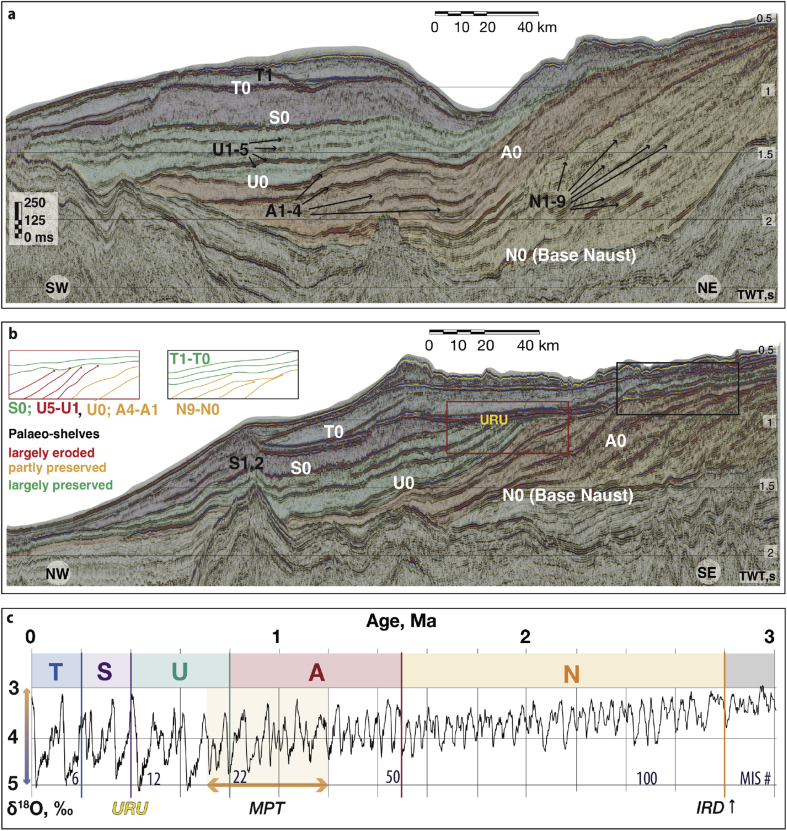
Regional seismic stratigraphy of the Naust Formation. a. From part of seismic profile GMNR94-302 (strike line) showing multiple coherent high-amplitude horizons (located in Fig. 1b). b. From part of a seismic profile GMNR94-106 (dip line) showing Naust sequences and degree of preservation of the buried surfaces (located in Fig. 1b). Surface N0 is the base-Naust. c. Tentative timeframe for the development of the Naust Formation (from Rise et al., 2010) juxtaposed with the δ18O marine-isotope curve as a proxy for global ice volume (from Lisiecki and Raymo, 2005). Annotations of major events to the left: IRD depicts ice-rafted debris increase in the early Quaternary (Jansen and Sjøholm, 1991). MPT – mid-Pleistocene Transition (1.2–0.75 Ma) (Clark et al., 2006). URU – regional erosional unconformity (Dahlgren et al., 2005;Ottesen et al., 2009).